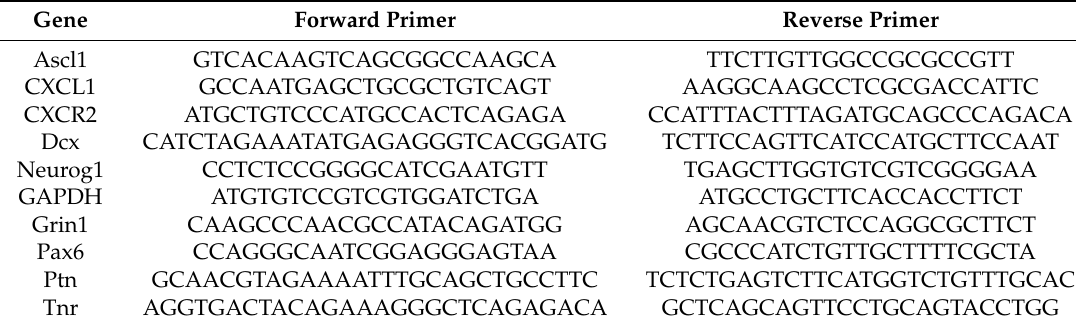
Table 2. Sequences of primers for quantitative